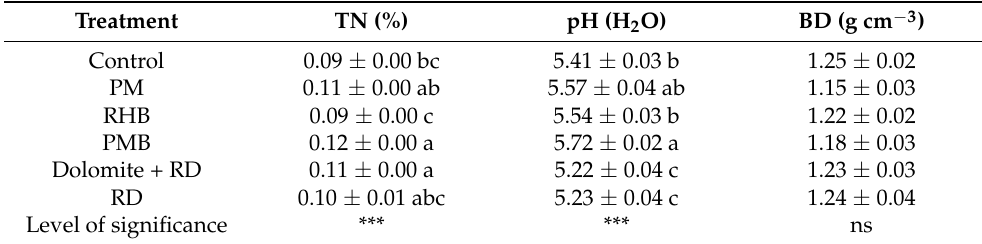
Table 4. Effects of different treatments on physicochemical properties of acidic